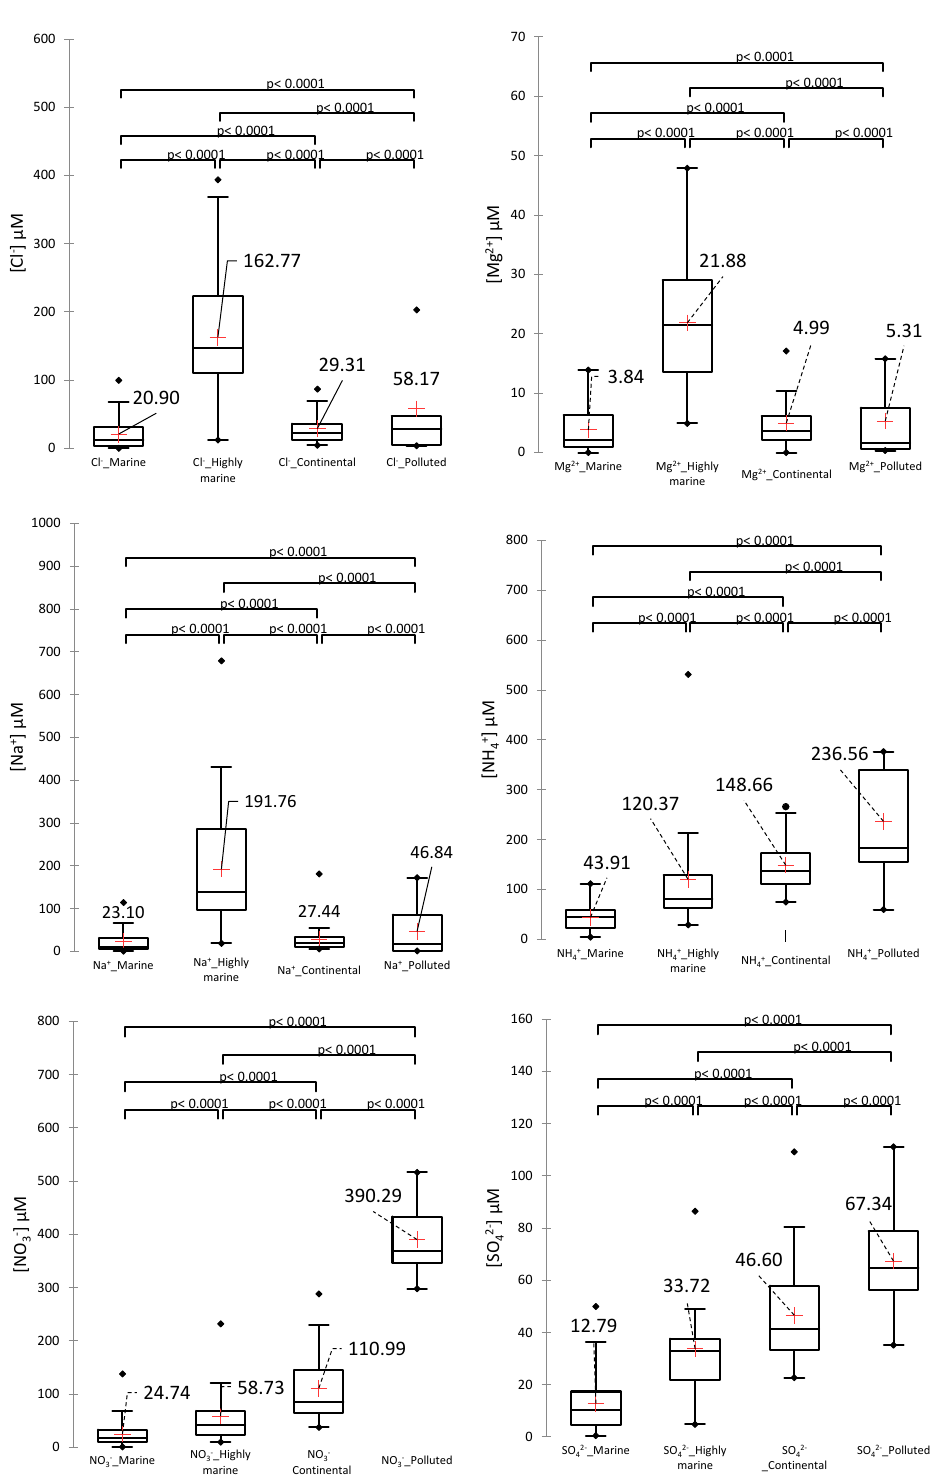
Figure 3. Distribution of inorganic ions (Cl − , Mg 2+ , Na + , NH 4+ , NO 3 , and SO 42− ) of the cloud waters sampled at PUY for each air mass category (marine, highly marine, continental, and polluted). The number of analyzed samples is 208 (samples with missing data were removed). One box plot per category is displayed for each ion. The mean values are displayed as red crosses. The central horizontal bars are the medians. The lower and upper limits of the box are the first and third quartiles, respectively. The ends of whiskers are 10th and 90th percentiles. Black diamonds are minimum and maximum for each species. The box plot’s horizontal width has no statistical meaning. Statistical differences (Kruskal–Wallis test; p value < 0.05) between groups are indicated above box plots.